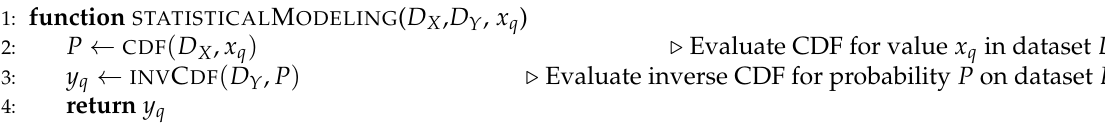
Algorithm 3 Statistical Bivariate Numerical Modeling (for monotonically increasing